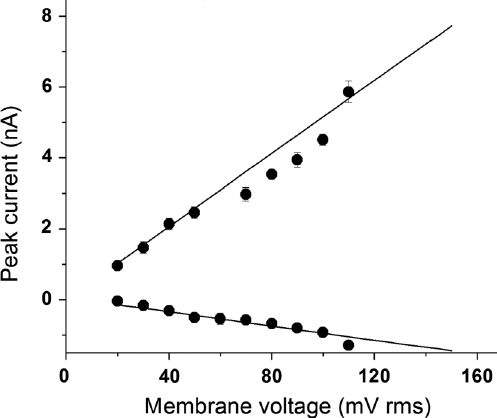
FIG. 8. The peak current (for both positive and negative swings) measured for the varying amplitude of the driving for (cid:3) ¼ 5 Hz . All points on the graph are obtained voltage V 0 from the same bilayer sample. There are two main features: The positive and negative branches are asymmetric, and both are . The error bars show 1 standard approximately linear with V 0 deviation corresponding to approximately five measurements of the type of Fig. 9. The solid lines are a fit produced by the model described in the